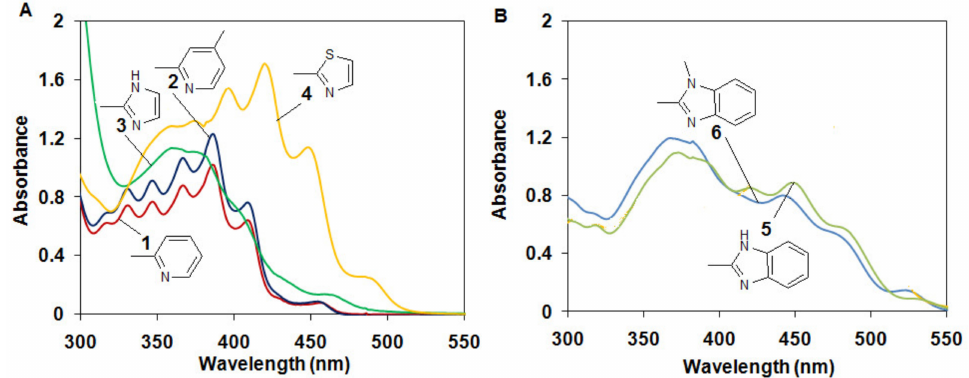
Figure 1. Electronic spectra of [Mn II (HL n )Cl 2 ] (HL = 1,3-bis(2’-Ar-imino)isoindoline) complexes in DMF solution with nonannulated (Ar = pyridyl (n = 1), 4-methylpyridyl (n = 2), imidazolyl (n = 3), thiazolyl (n = 4)), aromatic side chains ( A ) and annulated Ar = benzimidazolyl (n = 5) and N -methylbenzimidazolyl (n = 6) aromatic side chains ( B ).